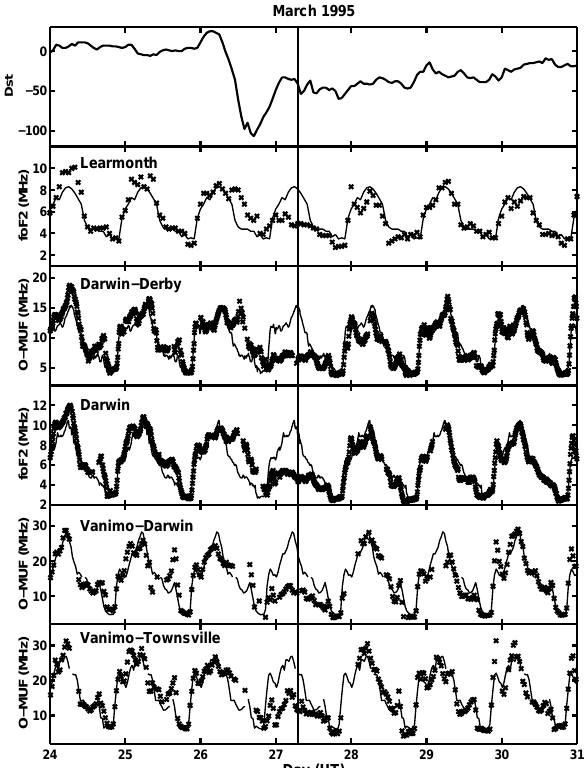
Fig. 3. D st , observed fo F2 and and maximum oblique-path o-ray frequency values (crosses) and associated medians (line) for the pe- riod 24–31 March 1995. The TOPEX/Poseidon pass on the negative ionospheric storm day of 27 March is also shown (vertical line).